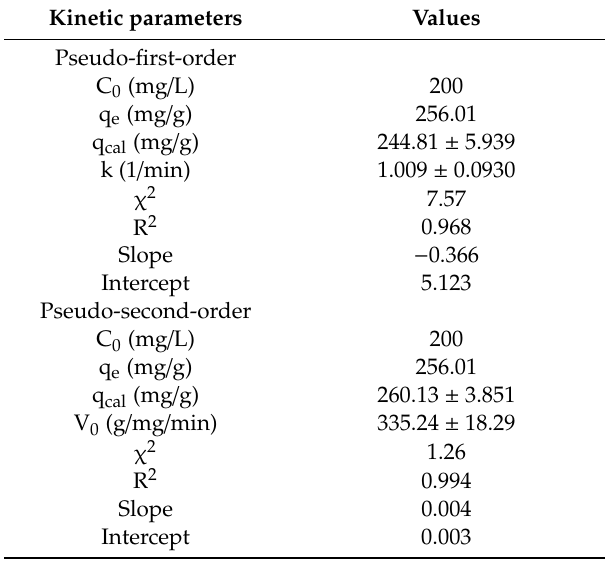
Table 1. The constants obtained from the kinetic parameters for RB5 adsorption onto Ct-PAC-HDA beads.